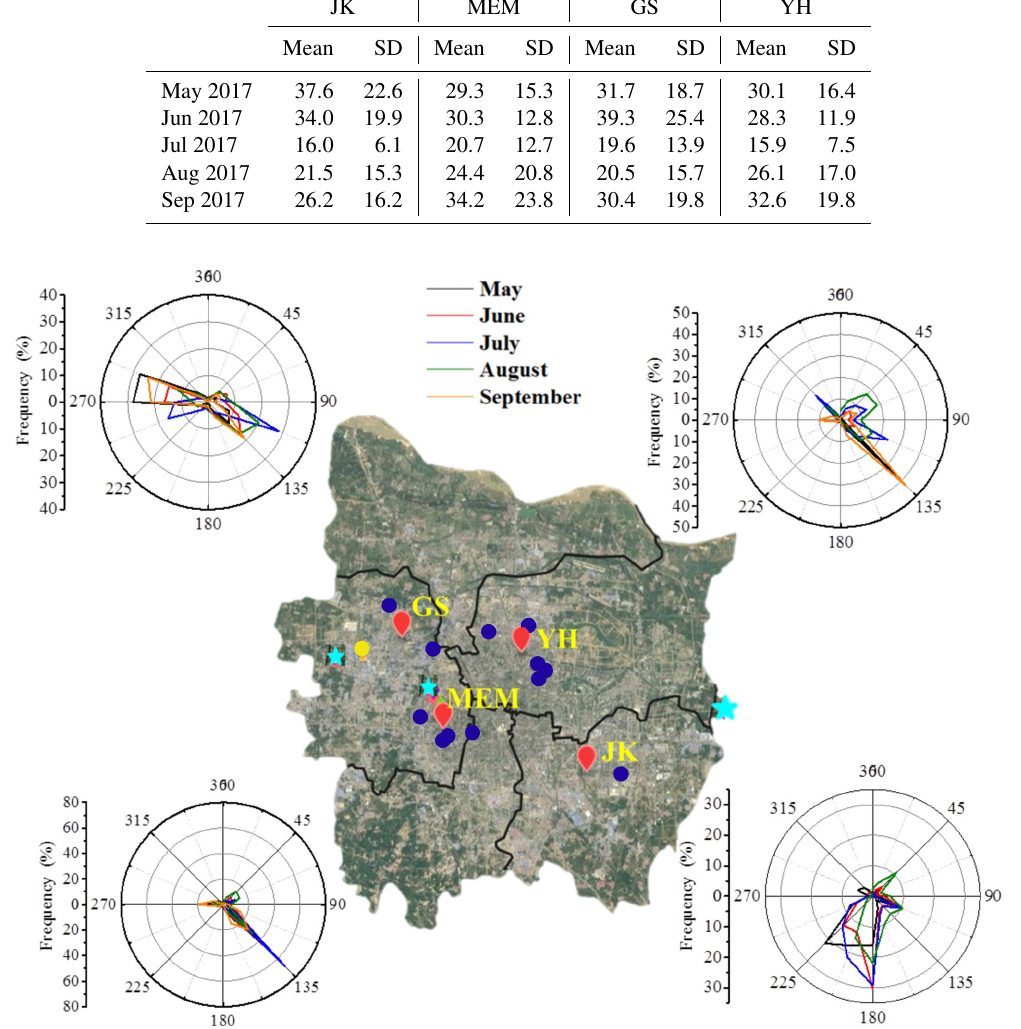
Figure 2. Wind direction for each site during May to September 2017.